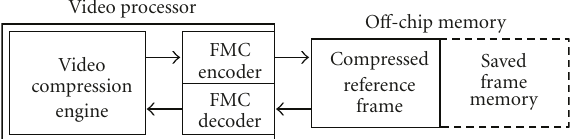
Figure 1: Video processor with an integrated FMC encoder and